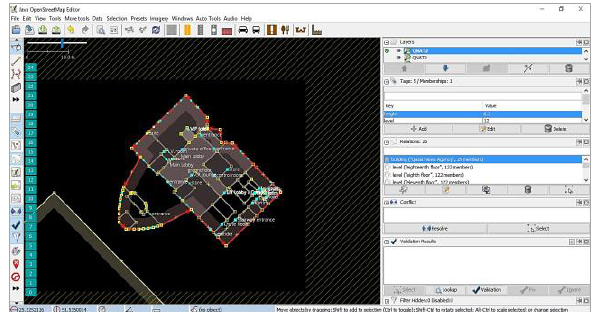
Figure 6. Mapping of indoor objects